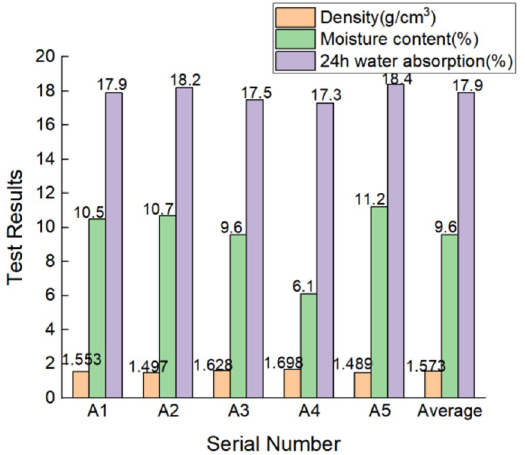
Figure 14. Bar charts of density, moisture content, and water absorption of each sample.